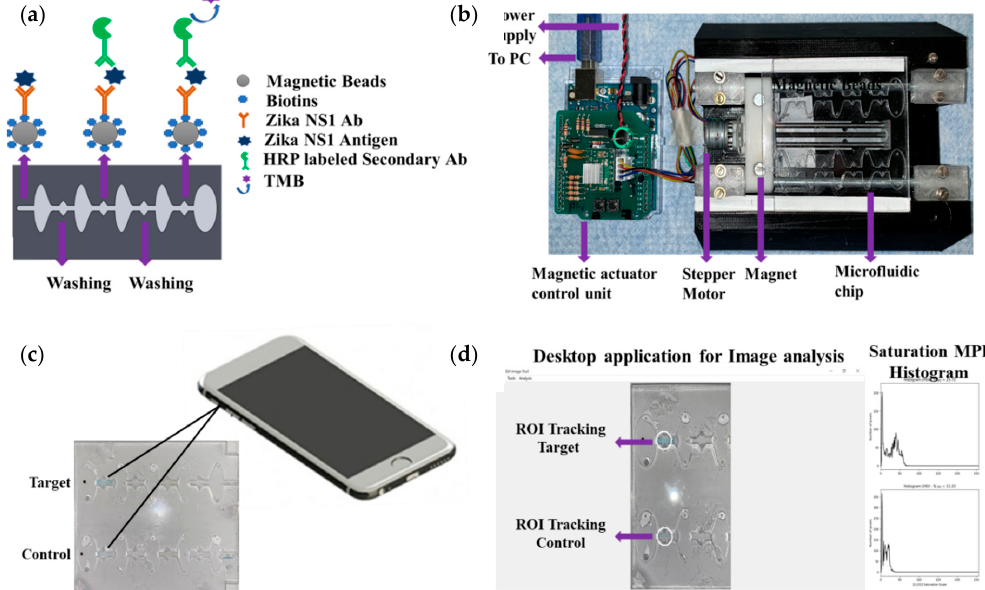
Figure 1. Graphical representation of the microfluidic sandwich enzyme-linked immunosorbent assay (ELISA) inside of a microfluidic chip. ( a ) Captured antigen is loaded inside the chip and moved through a washing bu ff er. The antigen-captured beads are labeled with the HRP-conjugated secondary antibody in the next chamber. After moving through a washing bu ff er chamber again, blue color was developed by reacting with a color-generation substrate. The reaction was stopped by moving the beads to a retention chamber. ( b ) A magnetic actuation platform containing an Arduino-controlled stepper motor unit. The 3D printed platform facilitates stepper motor housing allowing the user to move the magnets according to the command set up using a PC. The platform also holds the microfluidic chip just above the magnets. ( c ) Video frames of developed color on the chip are directly captured by a smartphone. ( d ) Region-of-interest (ROI) tracking using a desktop application and a histogram plot of the saturation maximum pixel intensity (MPI) of the developed color by the microfluidic magnetic enzyme linked immunosorbent assay (M-ELISA) on